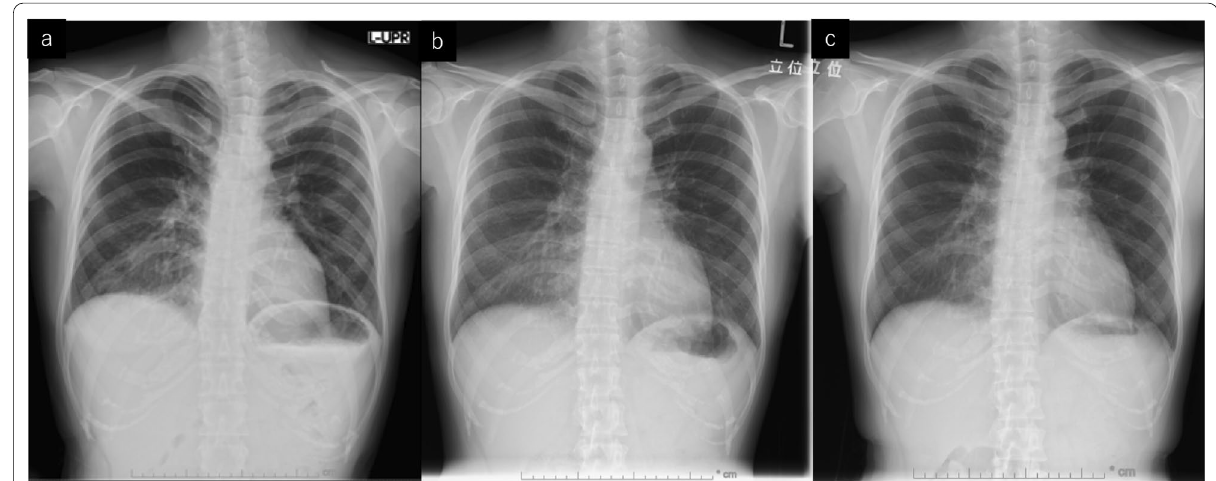
Fig. 2 Chest X-ray findings. a X-ray on day of COVID-19 diagnosis indicating infiltrative shadows in the peripheral lesion of both lungs. b X-ray after 2 weeks from discharge showing benign organized pneumonia in both lungs. c X-ray 3 months after discharge showing the dissipation of organized pneumonia